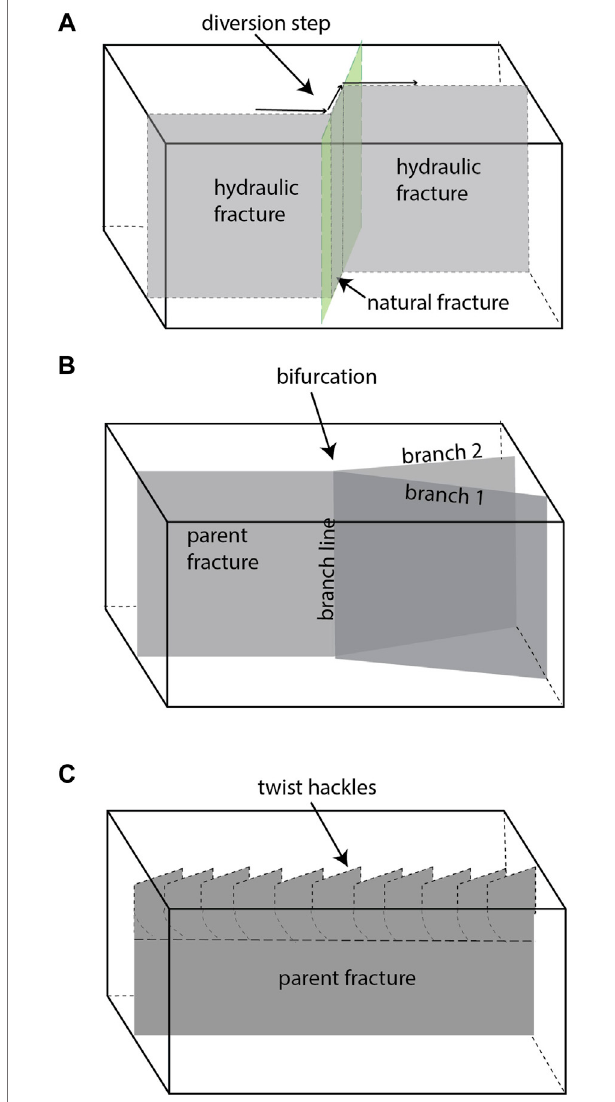
FIGURE 1 | Schematic block diagrams of fracture morphological features observed in this study. (A) Hydraulic fracture diversion step along a natural fracture. (B) Fracture bifurcation, where a single parent fracture splits into two, non-parallel fractures. (C) Segmentation of a parent fracture into twist hackles oblique to the